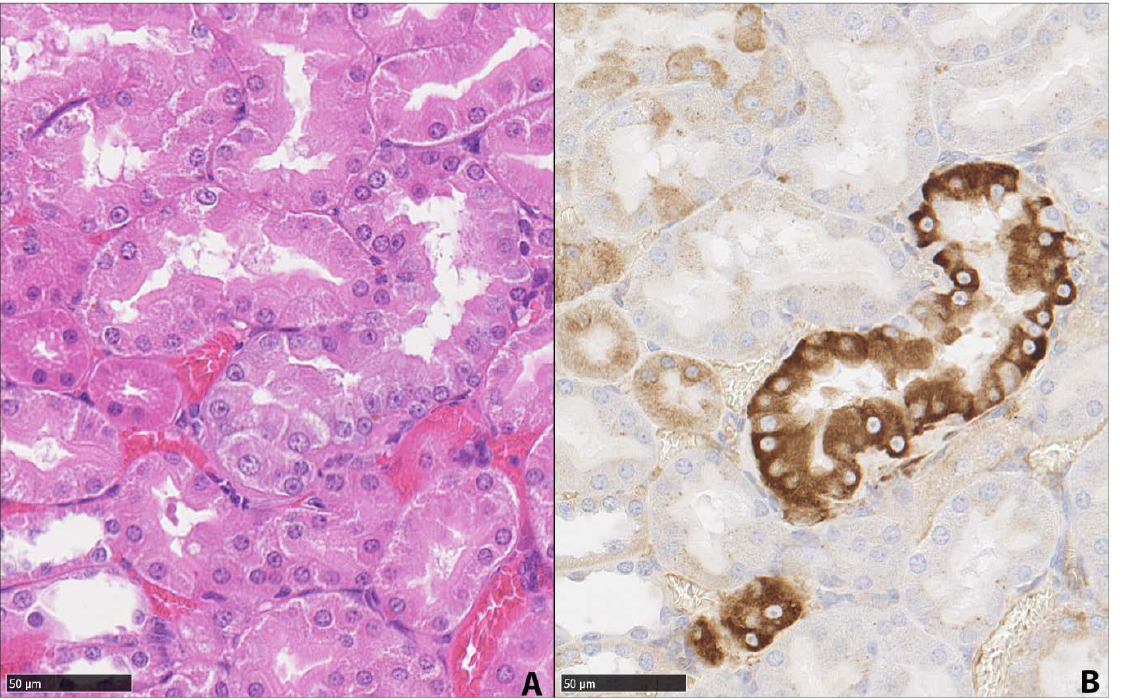
Figure 4. Seven months after oral gavage with AA. Adjacent sections in renal outer stripe of the outer medulla stained with haematoxylin and eosin ( A ), or immunohistochemically for expression of p-S6 protein ( B ). Stained nephron fragment(s) are interpreted as indicative of a pre-neoplastic lesion (bar 50